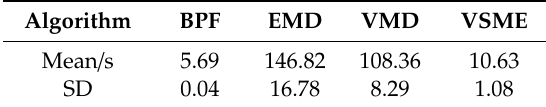
Table 3. Mean and standard deviation (SD) of calculation